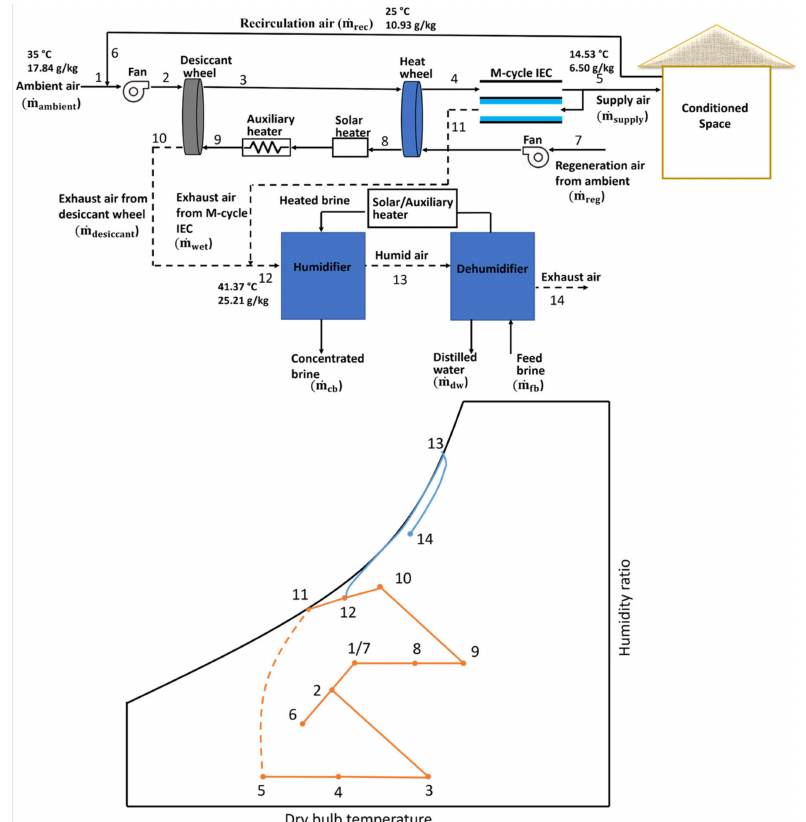
Figure 2. Schematic and psychrometric diagram of SDM-HDH in recirculation